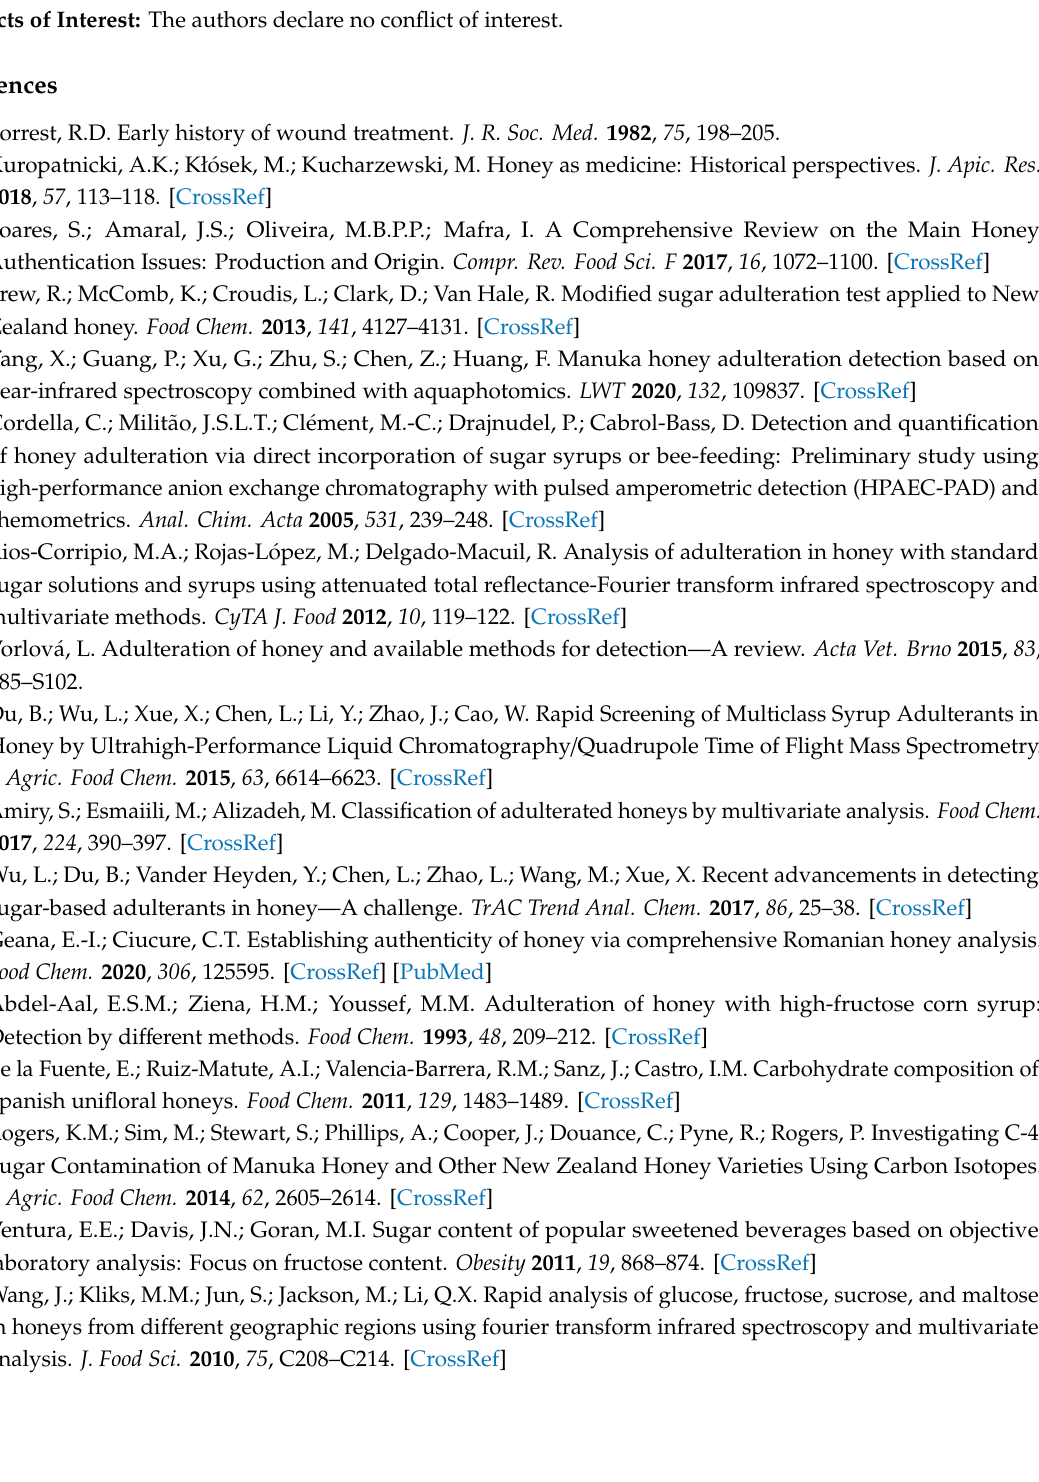
Supplementary Materials: The following are available online, Figure S1: Calibration Curves of Fructose (AU vs. Quantity), Figure S2: Calibration Curves of Glucose (AU vs. Quantity), Figure S3: Calibration Curves of Sucrose (AU vs. Quantity), Figure S4: Calibration Curves of Maltose (AU vs.